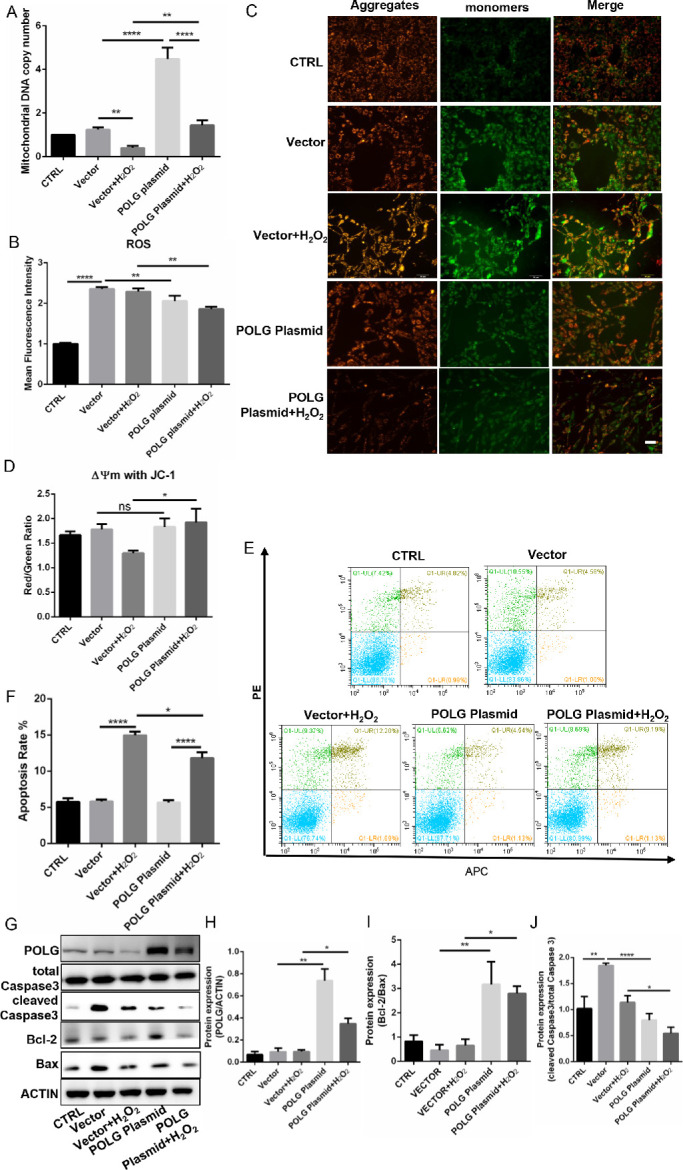

POLG maintained cell viability. (A) MtDNA copy number examination by RT-qPCR. (B) Flow cytometric detection of the mean fluorescence intensity of ROS in the cells transfected with the null vector or the POLG plasmid under oxidative stress. (C, D) Fluorescence microscopy and microplate spectrophotometry analysis of MMP by JC-1 staining. The JC-1 monomer was green, representing a low MMP, and JC aggregates were red, representing a high MMP. (E) Cell apoptosis detected by flow cytometry. (F) Apoptosis rate quantification of E. (G) Western blot analysis of apoptosis-associated proteins and POLG expression. (H–J) Quantification of the Western blot results. Scale bar: 100 µM. *P < 0.05, **P < 0.01, ****P < 0.00001, ns: P > 0.05.